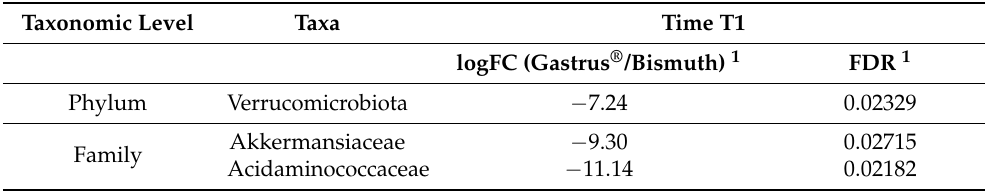
Table 3. List of differential abundant taxa between Gastrus ® group and Bismuth group. Taxa with statistically significant difference (FDR < 0.05) identified in at least 50% of the samples in at least one